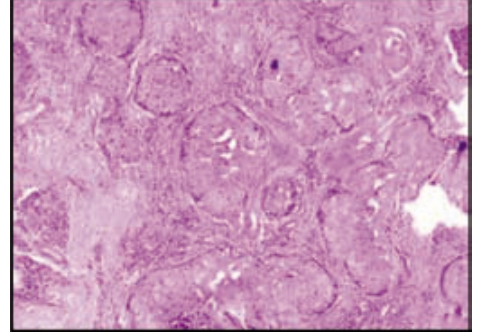
Fig.2. Carcinosarcoma - both epithelial and mesenchymal portions with neoplastic changes (H&Ex200)